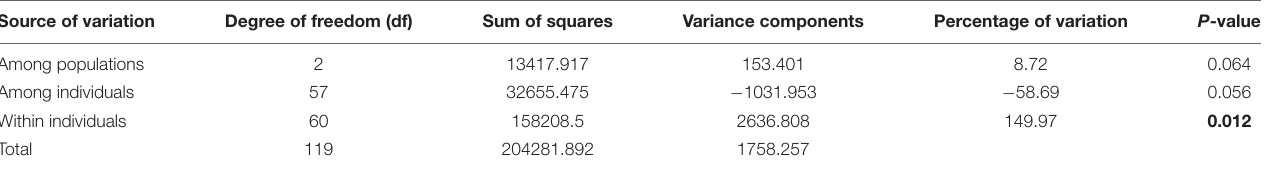
TABLE 3 | G. uralensis population analysis of molecular variance. Source of